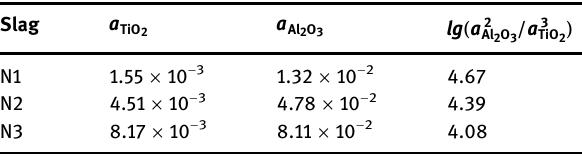
Table 4: Activities of TiO 2 and Al 2 O 3 in the slag and values